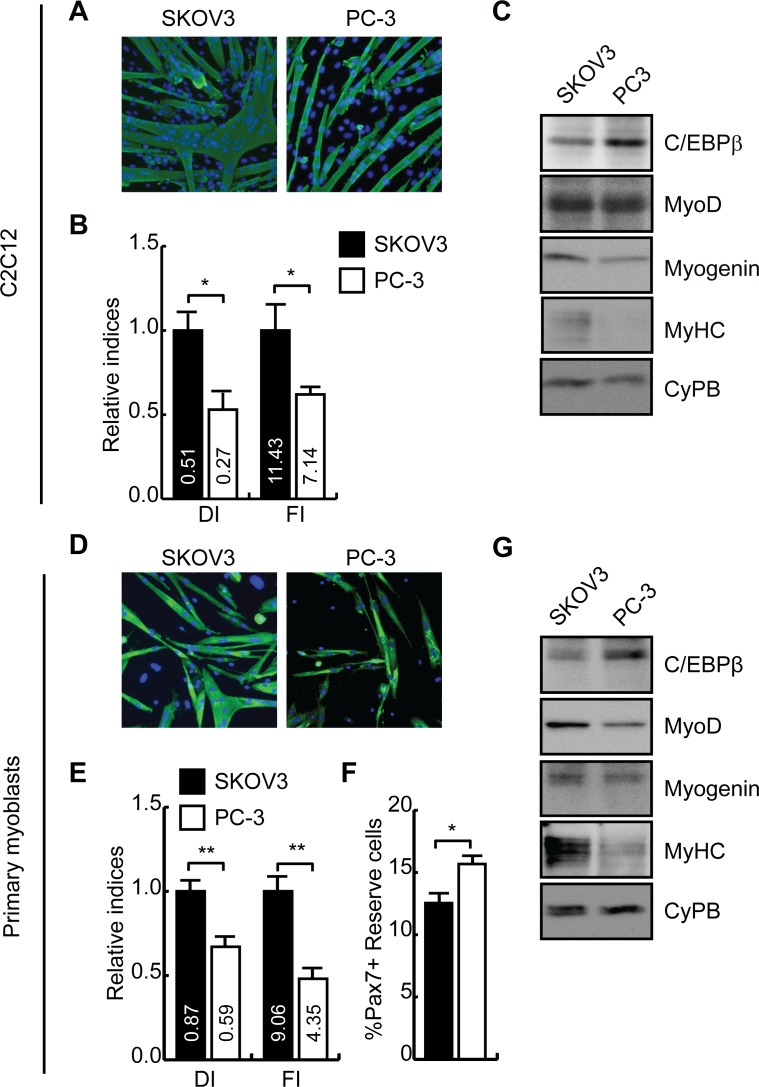
Inhibition of myogenesis correlates with induction of C/EBPβ expression in myoblasts.
(A) Immunocytochemistry staining of myosin heavy chain expression in C2C12 myoblasts pre-treated with conditioned media from SKOV3 or PC-3 cells mixed 1:1 with fresh media, for 48hrs, and induced to differentiate for an additional 5 days. DAPI stains nuclei blue. (B) C2C12 cultures were induced to differentiate as in (A) and the differentiation and fusion indices were calculated as relative to SKOV3-treated cells. Actual values are shown in the respective bars. *p<0.05, n = 5. (C) C/EBPβ, and myogenic marker protein expression in C2C12 myoblasts treated as in (A). Cyclophilin B (CyPB) is shown as a loading control. (D) Immunocytochemistry staining of myosin heavy chain (MYH) expression in primary myoblasts pre-treated with conditioned media from SKOV3 or PC-3 cells mixed 1:1 with fresh media, for 48hrs, and induced to differentiate for an additional 48 hours in DMEM containing 10% horse serum. DAPI stains nuclei blue. (E) Primary myoblast cultures were induced to differentiate as in (D) and the differentiation and fusion indices were calculated as relative to SKOV3-treated cells. Actual values are shown in the respective bars. **p<0.01, n = 4. (F) Percentage of Pax7+ cells relative to total nuclei remaining in C2C12 cells cultured in conditioned medium and differentiated as in (D) as determined by immunocytochemistry. *p<0.05, n = 4. (G) C/EBPβ, and myogenic marker protein expression in primary myoblasts treated as in (D). Cyclophilin B (CyPB) is shown as a loading control.